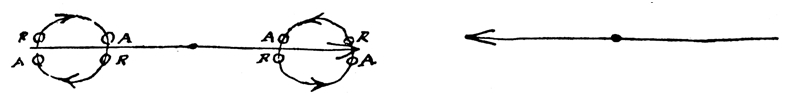
 The wire is construed as circling the needle.